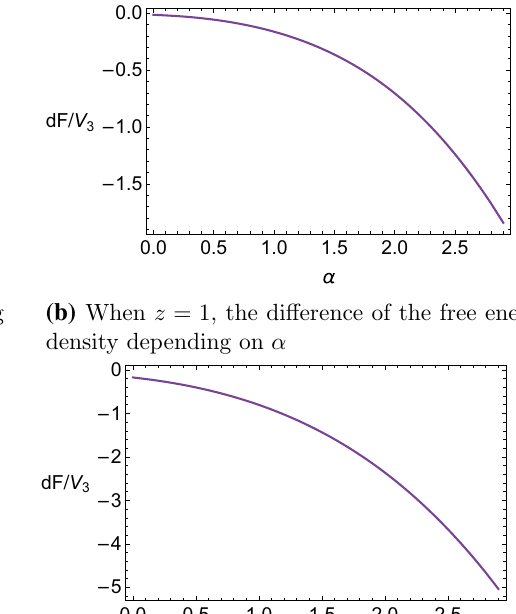
(c) When z = 2, the free energy density depending